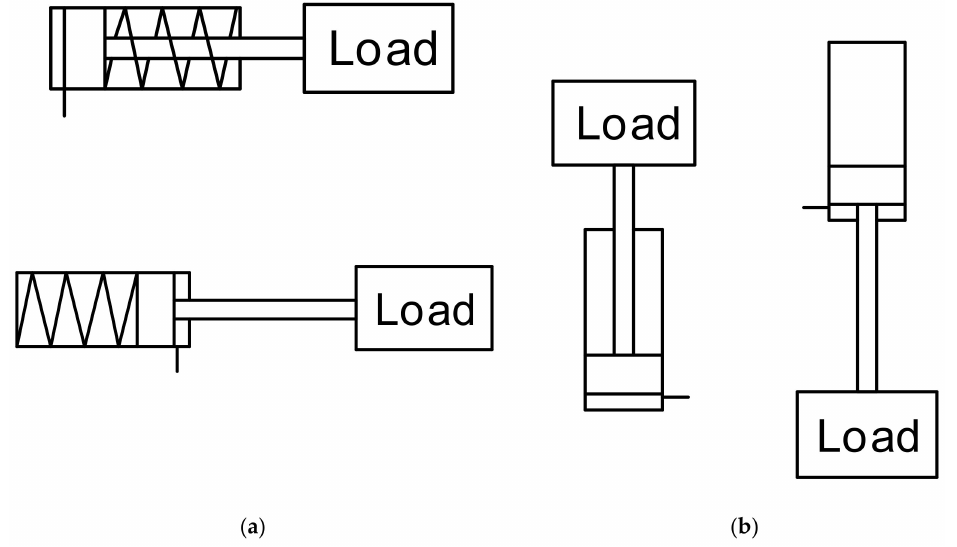
Figure 1. Example of a single-acting actuator: ( a ) spring return; ( b ) gravity return.